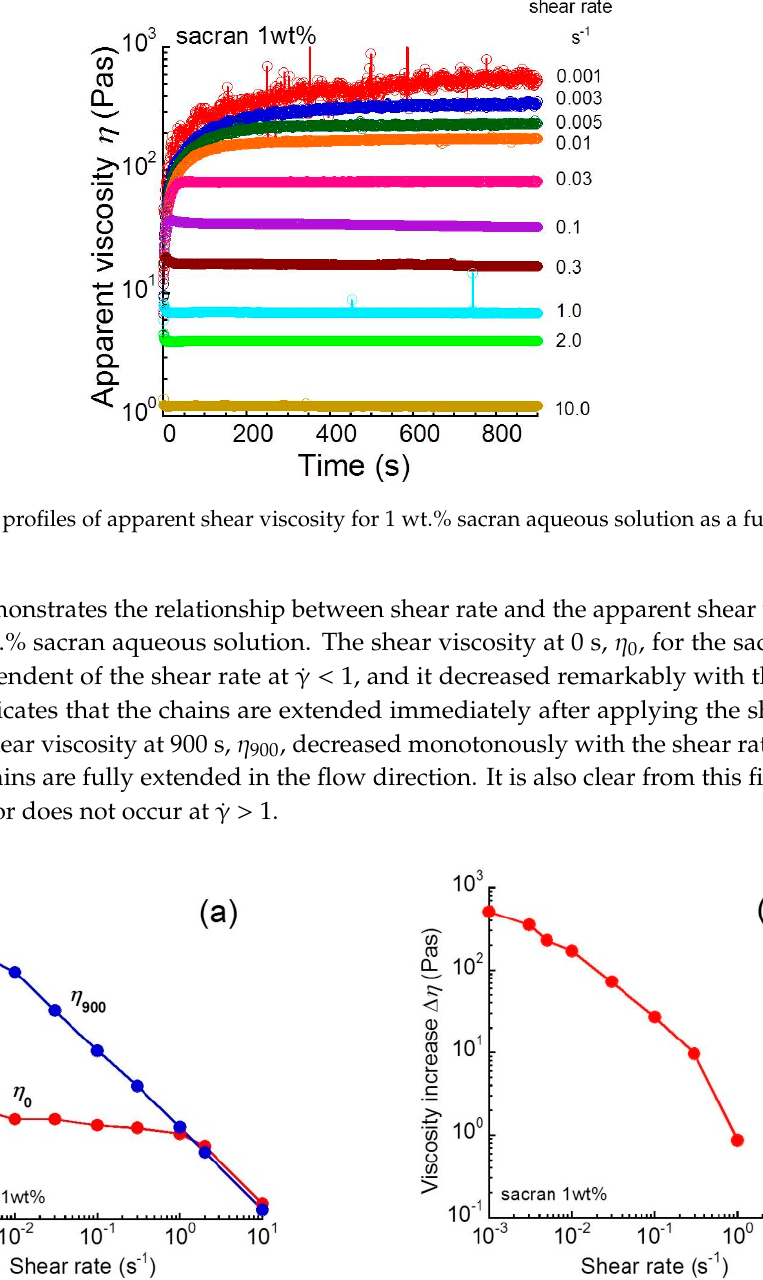
Figure 2. ( a ) Relationship between shear rate and apparent shear viscosity at 0 and 900 s; ( b ) relationship between the viscosity increase and shear rate for 1 wt.% sacran aqueous solutions. Figure 3 indicates the time profiles of apparent shear viscosity at a shear rate of 0.01 s − 1 for sacran